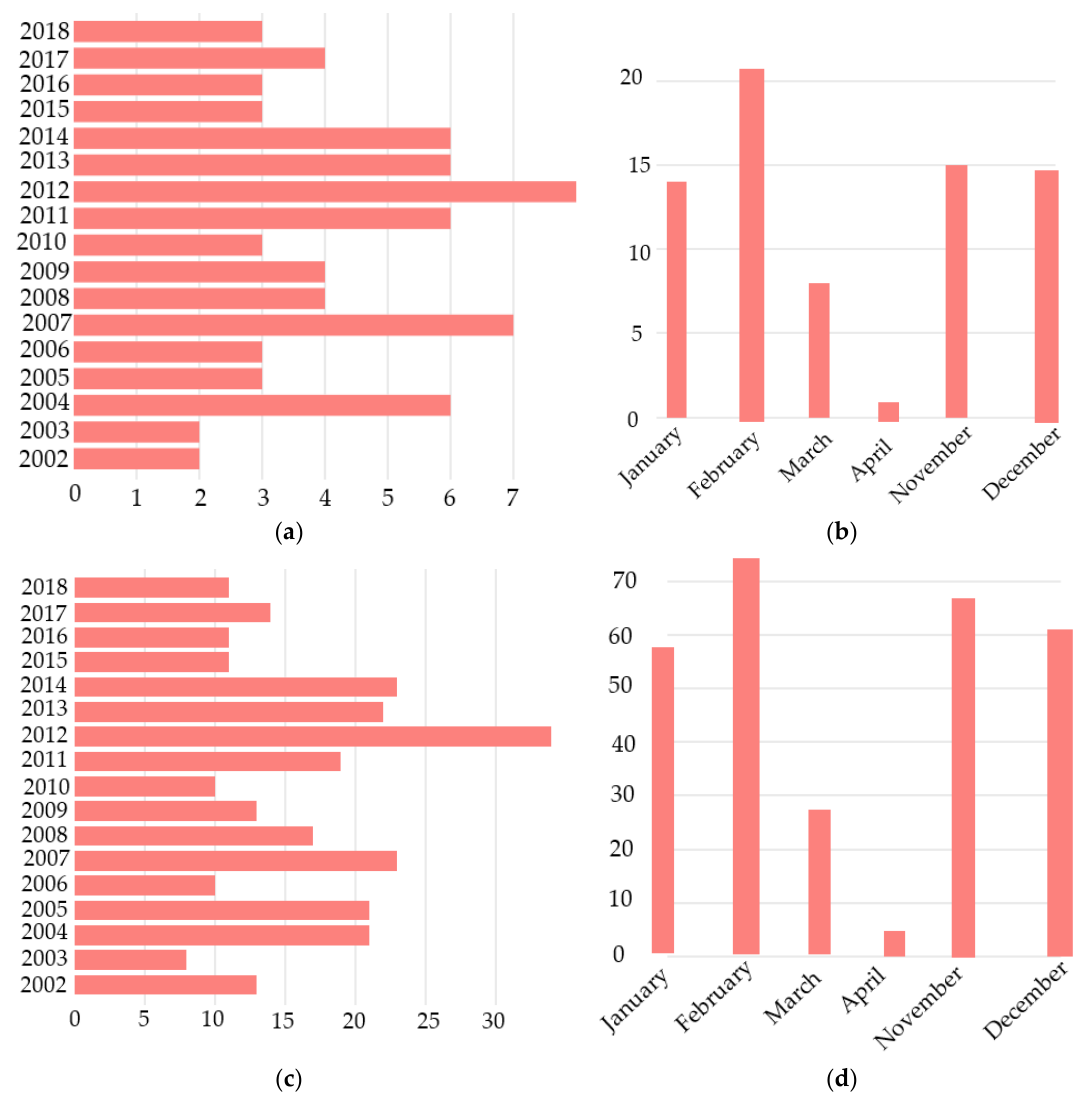
Figure 5. Generic statistics of whiting occurrence: ( a ) total frequency per year, ( b ) total frequency per month, ( c ) total number of days per year and ( d ) total number of days per month.